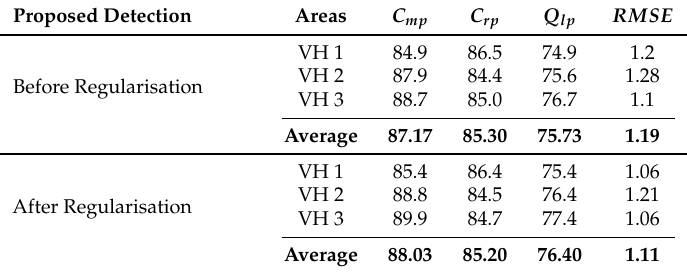
Table 3. Pixel-based building detection results on the Vaihingen (VH) data set before and after regularisation stage. ( C mp = completeness, C rp = correctness and Q lp = quality are in percentage, RMSE = planimetric accuracy in